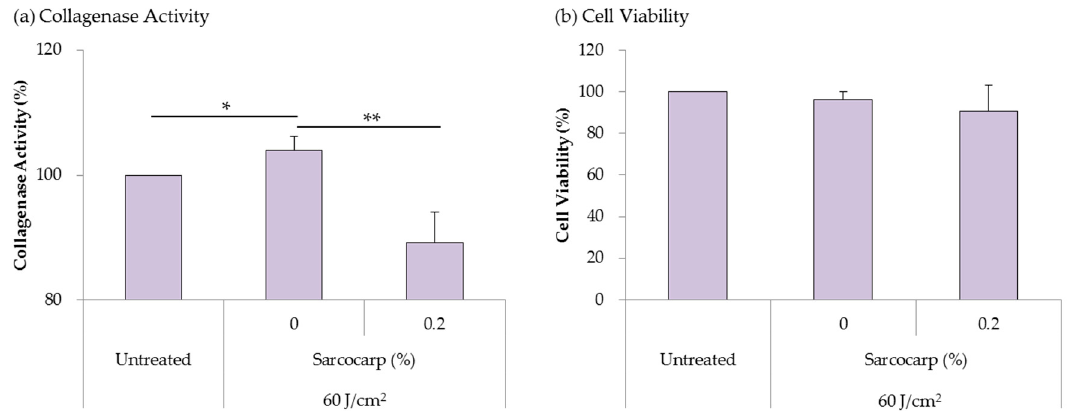
Figure 4. The human skin model was irradiated with UV. ( a ) The changes in collagenase activity. ( b ) The human skin model viability. The sample concentration is described as the solid concentration. Results are expressed as the mean ± SD (n = 3) (* p < 0.05, ** p < 0.01).